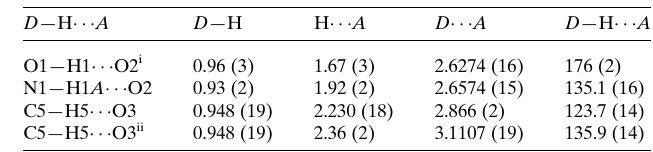
Table 1 Hydrogen-bond geometry (A˚ , (cid:5) ).